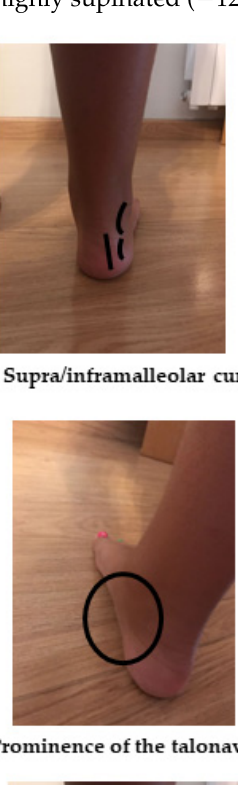
and metatarsal formula (Index plus, Index minus, and Index plus minus) were performed by an experienced podiatrist according to the criteria established by Young C et al. [35]. FPI measurements were assessed at baseline and repeated 36 months later, following the methodology of previous studies [32,36–39] by the same podiatrist (P.A.G). The FPI results shown in the study are for the right foot, which was chosen by randomization, although data from both feet were evaluated [32]. This index assesses the following criteria (Figure 1): talar head palpation, supra/inframalleolar curvature, calcaneal frontal plane position, prominence in the region of the talonavicular joint, congruence of the medial longitudinal arch, and abduction/adduction of the forefoot on the rearfoot. For each criterion, the score ranges from − 2 to +2. The total score obtained from the sum of the six criteria classifies the static posture of the foot into: highly pronated (10 to 12), pronated (6 to 9), neutral (0 to 5), supinated ( − 4 to − 1), and highly supinated ( − 12 to − 5).